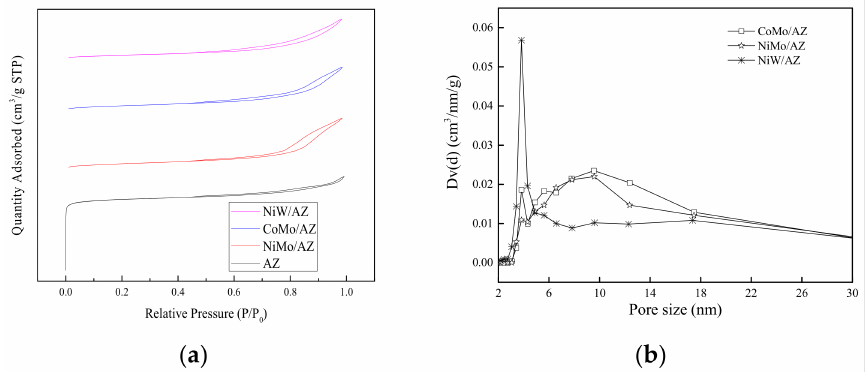
Figure 1. Physical properties of the catalysts. ( a ) Isotherm linear plot; ( b ) Pore size